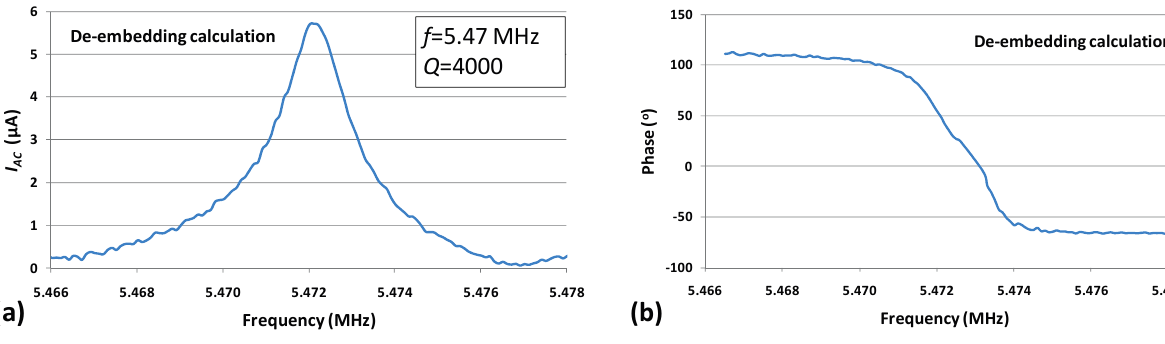
Figure 7. De-embedded piezoresistive current I AC ( a ) and phase ( b ) versus frequency with input power of 10 dBm. ( V DC = 3 V, Measurement bandwidth = 100